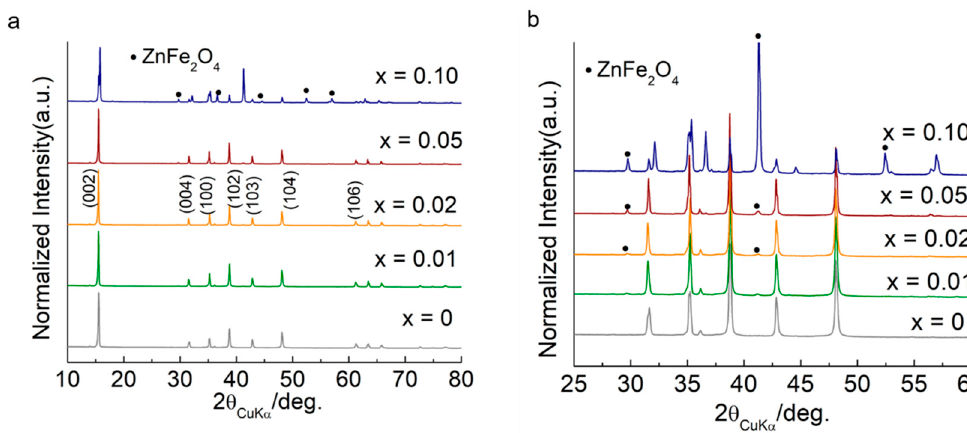
Figure 2. X-ray diffraction (XRD) patterns for P2-Na 0.60 Fe 0.5 Mn 0.5 − x Zn x O 2 (x = 0, 0.01, 0.02, 0.05, 0.10) cathodes powder in the 2 θ range ( a ) 10–80 ◦ ( b ) 25–60 ◦ , expanded view to observe the impurities formation from Zn-2 cathodes onwards. The impurities are marked with ( • ) representing ZnFe 2 O 4 .